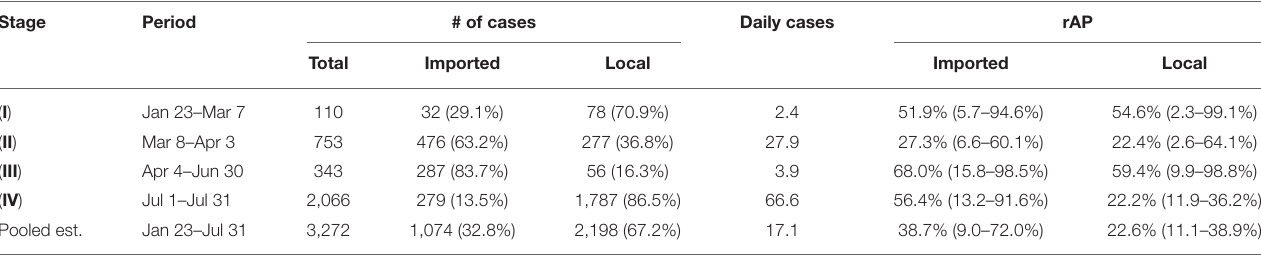
TABLE 1 | Summary of cases and the estimated asymptomatic proportions in the reported imported and local COVID-19 confirmed cases (rAP) at different stages of the epidemic in Hong Kong. Stage Period # of cases Daily cases rAP Imported Local